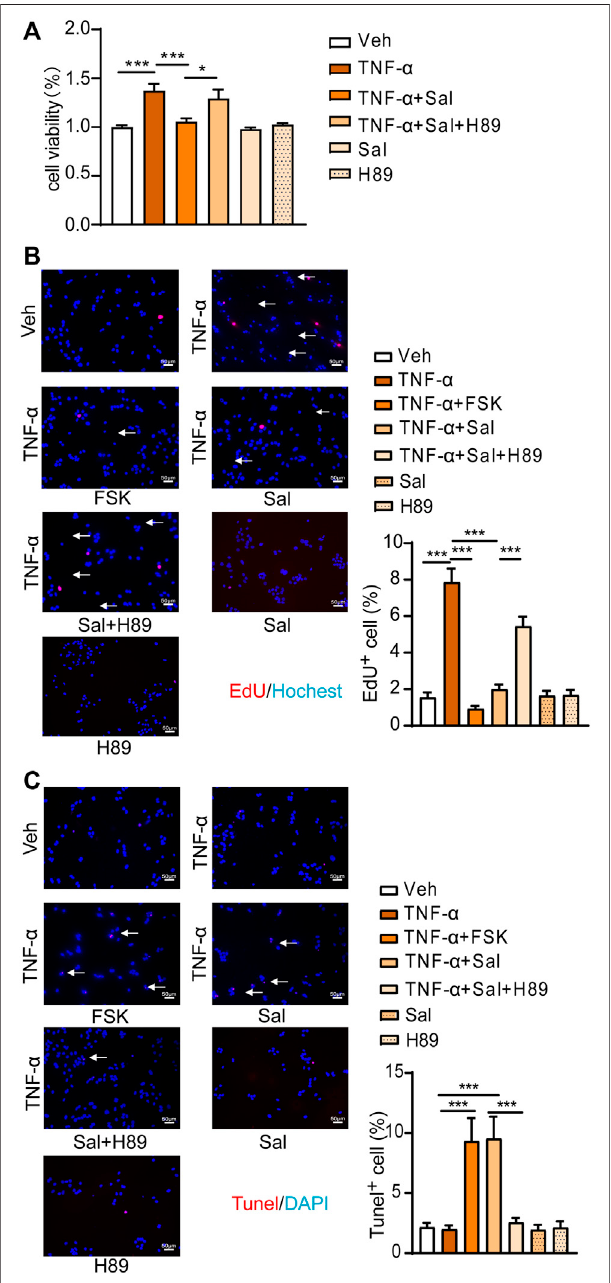
FIGURE3| SalmeterolregulatesTNF- α -stimulatedcellproliferationandthe apoptosis associated with activation of the cAMP/PKA pathway. HaCaT cells wereserumstarvedovernight.Duringtheexperiment,HaCaTcellswerecultured without serum. HaCaT cells were pretreated with the PKA inhibitor, H89 (1 μ M),for30 minfollowedbytreatmentwithSal(100 nM).After1 h,HaCaTcells wereexposedtoTNF- α (10 ng/ml)for48 h( n =3). (A) Cellviabilitywasmeasured by a CCK8 assay. (B) Cell proliferation was measured by EdU incorporation (×200,Scale bar= 50 μ m). (C) Cellapoptosis was measured by a TUNEL assay (×200, Scale bar = 50 μ m). Data are presented as the mean ± SEM. * p < 0.05 and *** p < 0.001 by one-way ANOVA followed by Tukey ’ s post-hoc test.